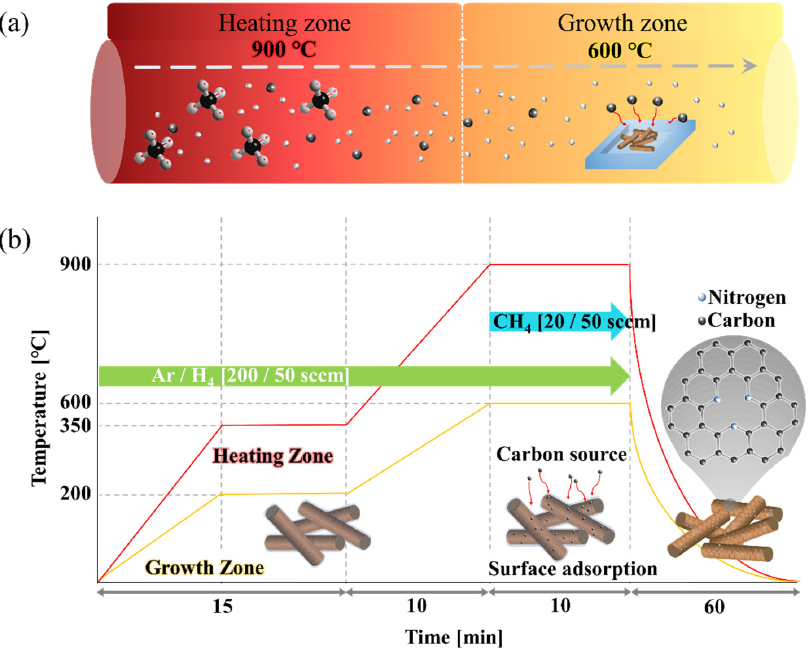
Figure 1. Schematic illustrations for processes in present work: ( a ) double zone growth method and ( b ) detailed method of graphene growth.